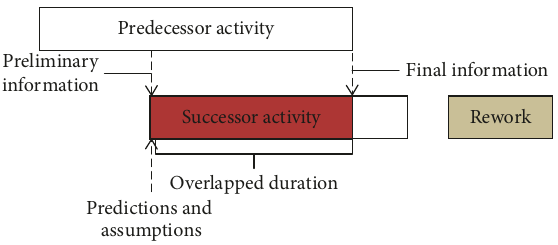
Figure 1: The mechanism of